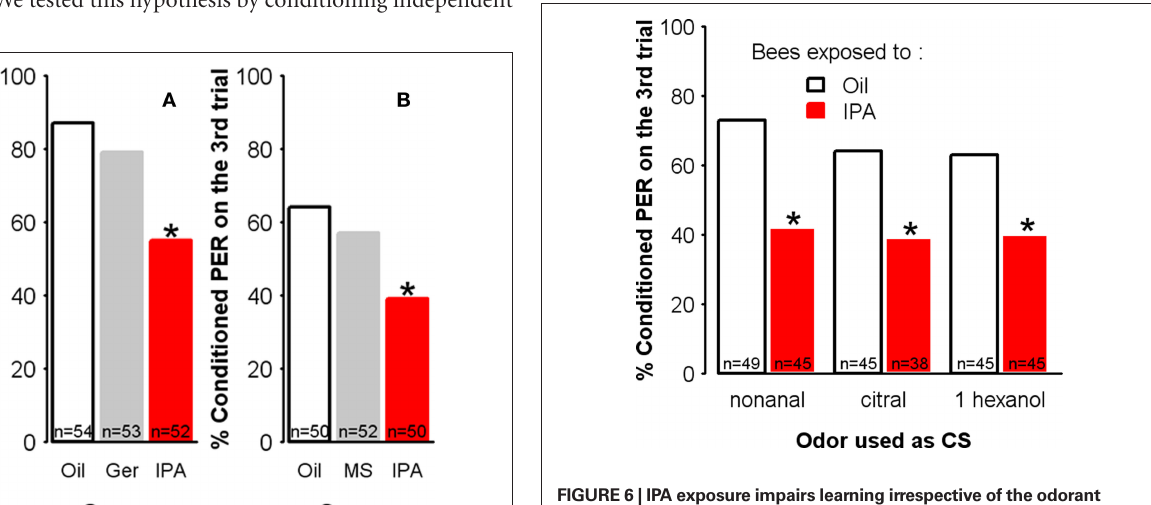
Figure 6 | iPA exposure impairs learning irrespective of the odorant used as the conditioned stimulus. Learning performances, as indicated by percentages of conditioned responses to the conditioned odor on the third trial (PER conditioning), for each group. Independent groups of bees were conditioned in a three-trial protocol, after exposure to either IPA (24% in mineral oil) or mineral oil alone. In each pair of groups, a different odorant (nonanal, citral, or 1-hexanol) was used as the CS during the three-trial conditioning. In all cases, control bees ( Oil ) learned significantly better than exposed bees ( IPA ). Thus, IPA exposure impairs subsequent associative olfactory learning irrespective of the odorant selected for conditioning. * p < 0.05 (as compared to respective Oil control groups).